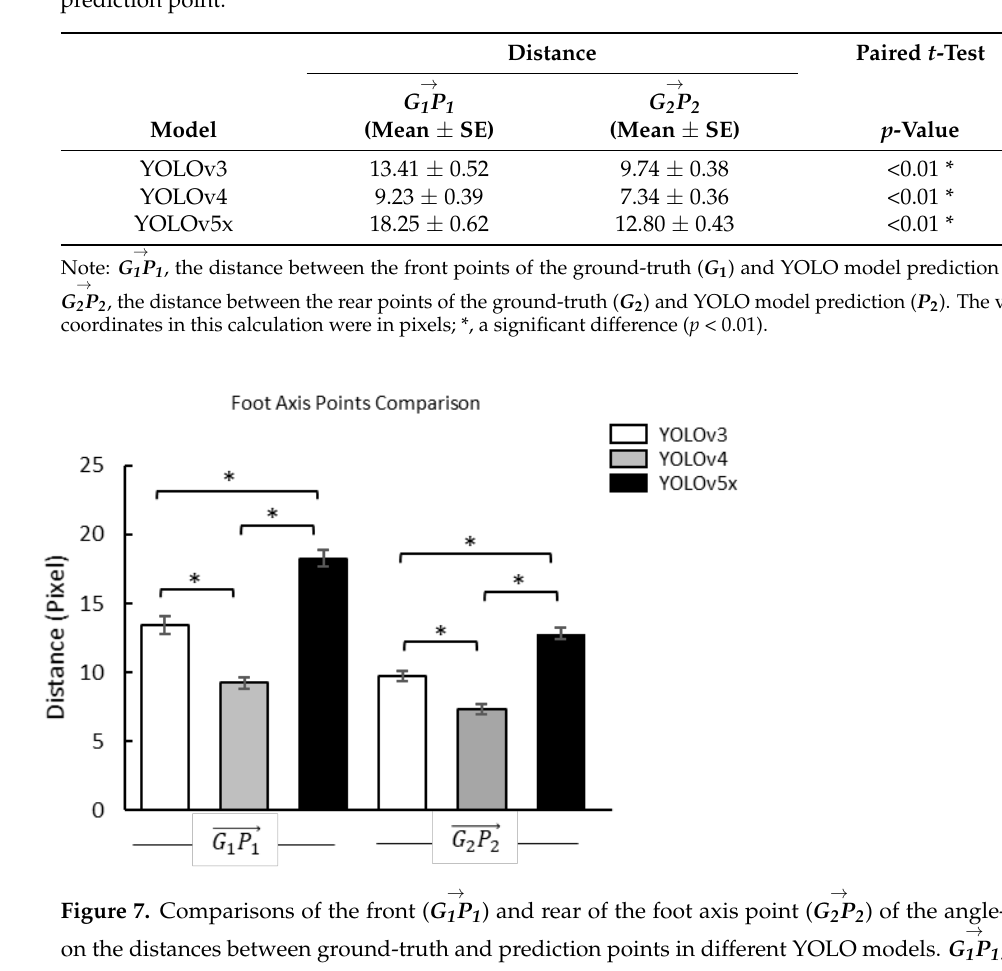
Table 4. Effect of different points of FPA on the distance between the ground-truth point and prediction point.